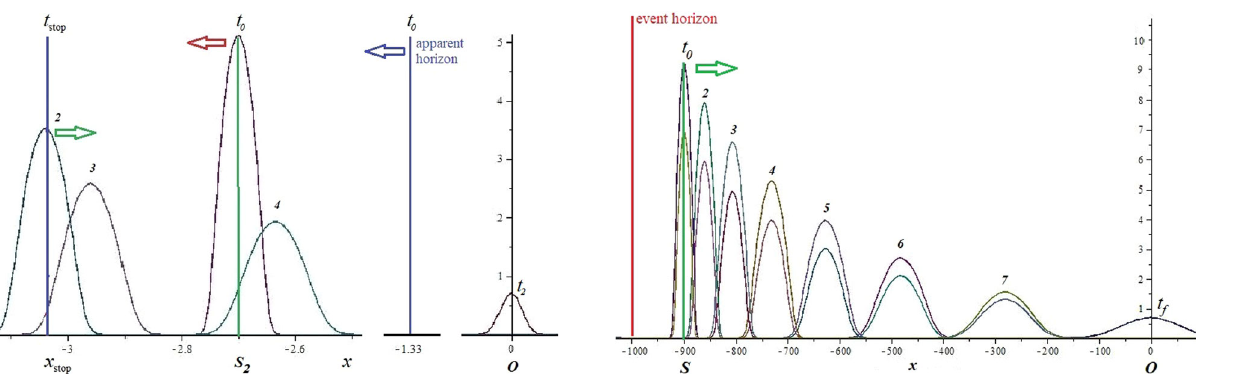
Fig. 4 The consecutive profiles in a logarithmic scale of intensity and density of a wave packet of a massless fermion emitted inside the event horizon. We observe the decay and dispersion